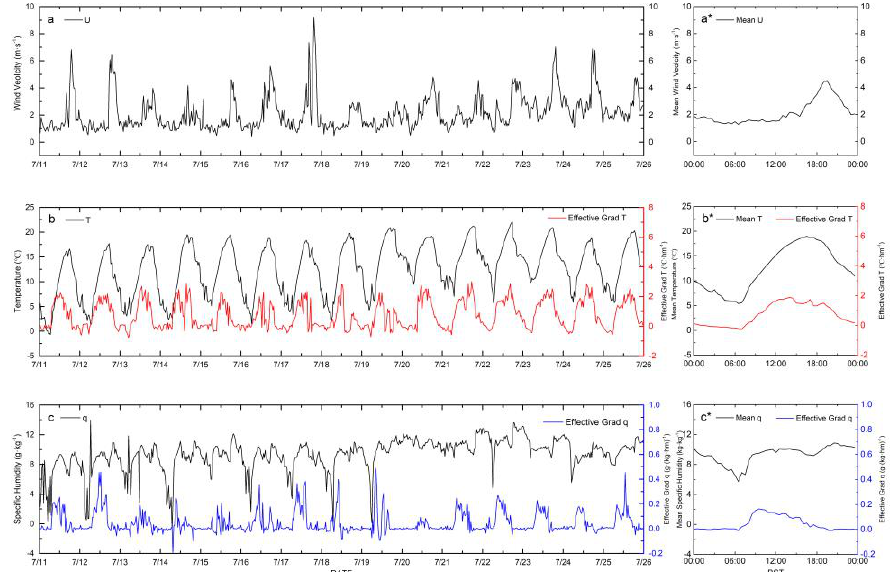
Figure 4. Time series of 2-m 30-min averaged ( a ) surface wind velocity, ( b ) temperature, and ( c ) moisture from 11 July to 25 July; ( a* – c* ) is the corresponding mean diurnal variations; red line: the component of temperature gradient in the direction of wind velocity; blue line: the component of specific humidity gradient in the direction of wind velocity; black line: ( a ) surface wind velocity, ( b ) temperature, ( c ) specific humidity.